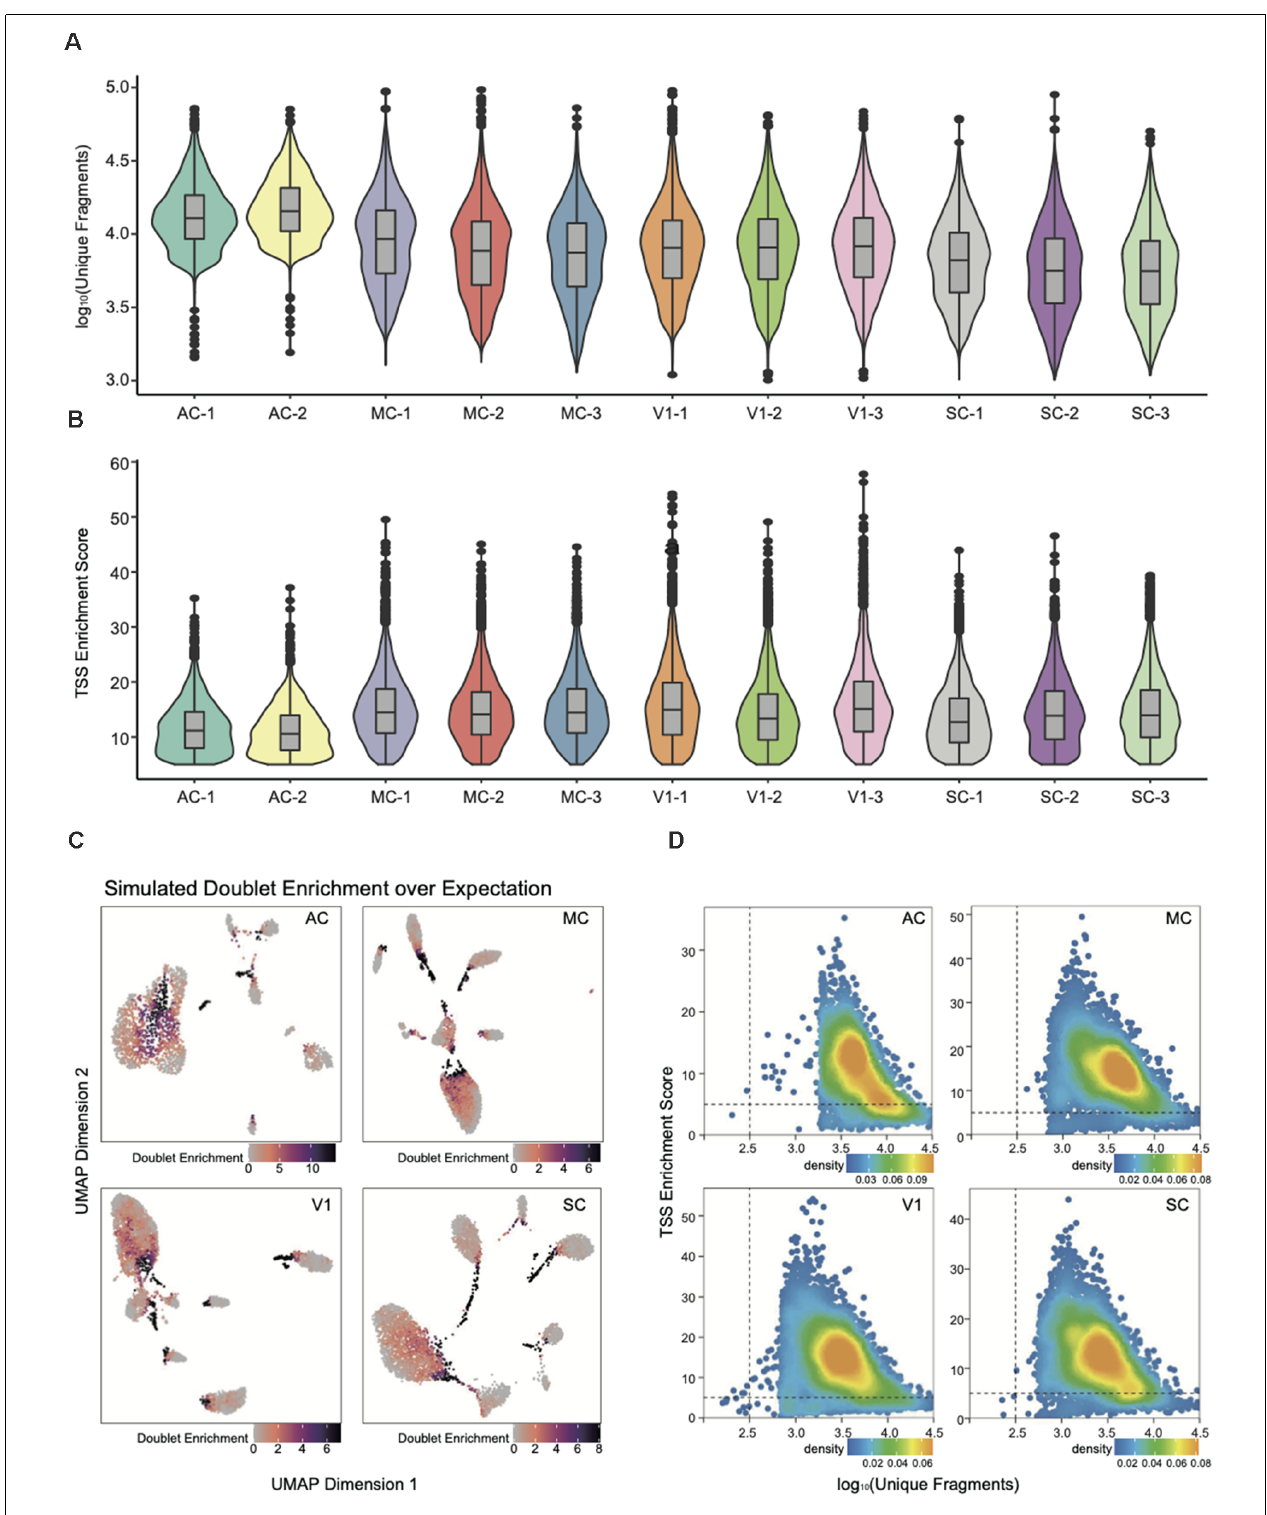
FIGURE 2 | snATAC-seq data quality metrics. (A) Violin plot for the number of unique nuclear fragments per library. (B) Violin plot for the distribution of transcription start site (TSS) enrichment score per library. (C) UMAP of snATAC-seq data showing the simulated doublet enrichment over expectation based on genotyping information. (D) Quality control (QC) filtering plots for the auditory cortex (AC), motor cortex (MC), primary visual cortex (V1), and somatosensory cortex (SC) dataset showing the TSS enrichment score vs. unique nuclear fragments of each nucleus.